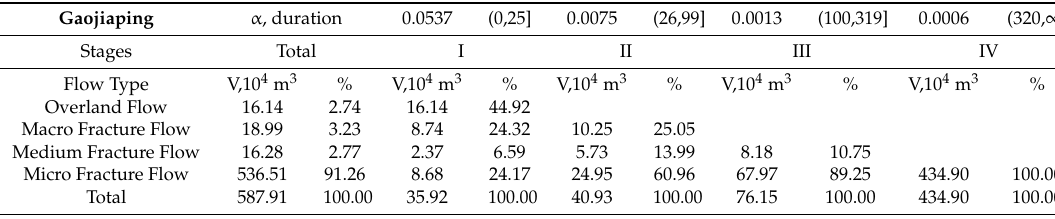
Table 5. Table of streamflow Component Separation for Gaojiaping